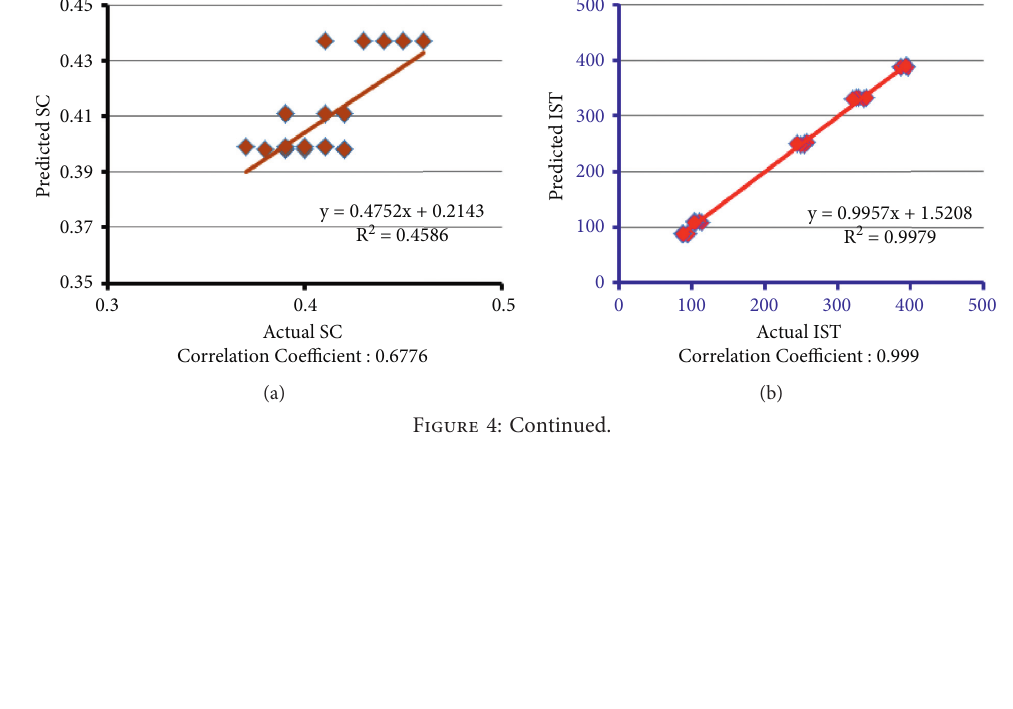
Figure 3: Physical properties of PPC for BA as a replacement. (a) Standard consistency; (b) initial setting time; (c) final setting time; (d) compressive strength of